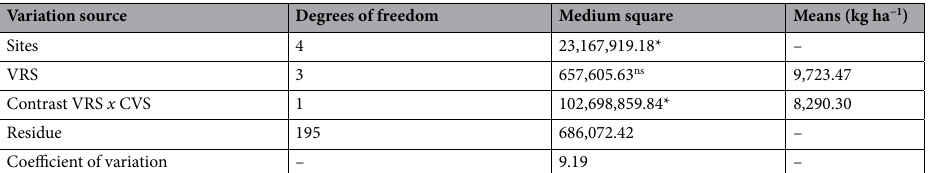
Variation source